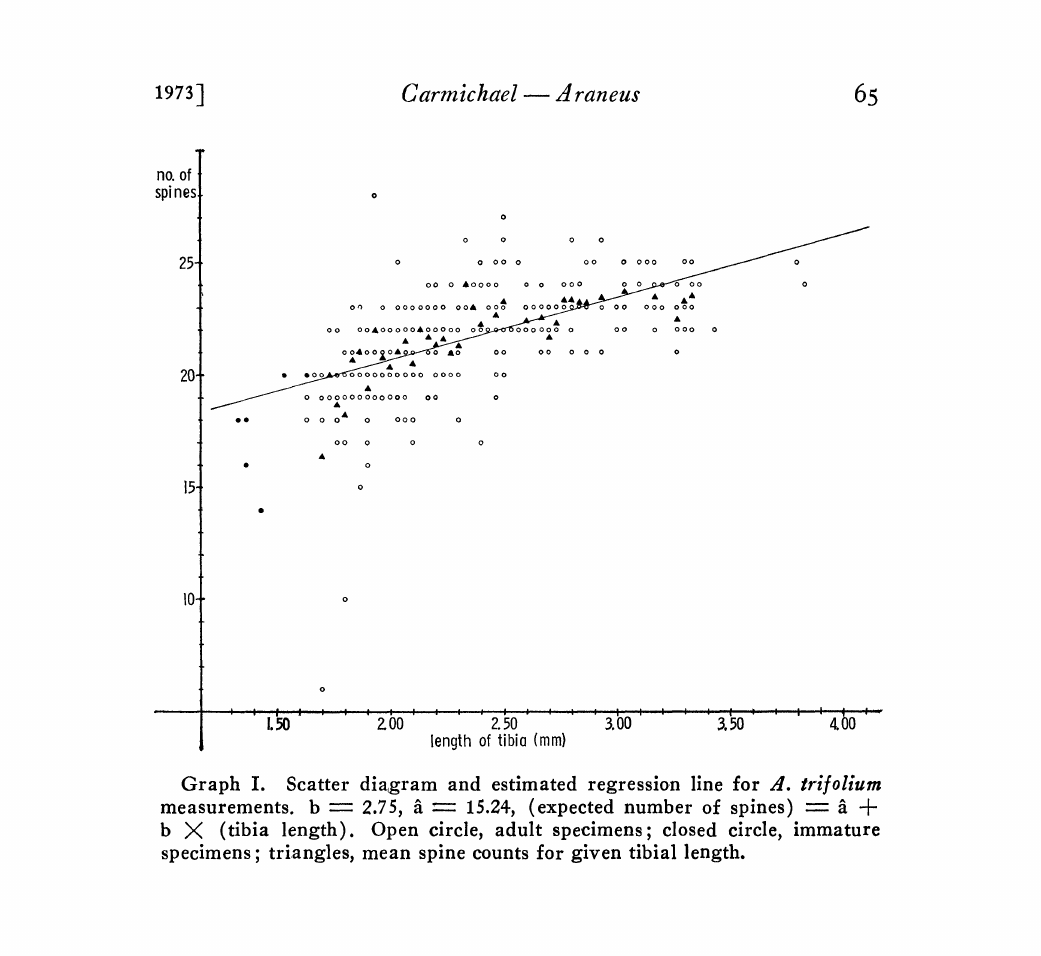
-- Graph I. Scatter dia, gram and estimated regression line for A. trifollum 15.24, (expected number of spines) measurements, b 2.75, $ b X (tibia length). Open circle, adult specimens; closed circle, immature specimens; triangles, mean spine counts for given tibial